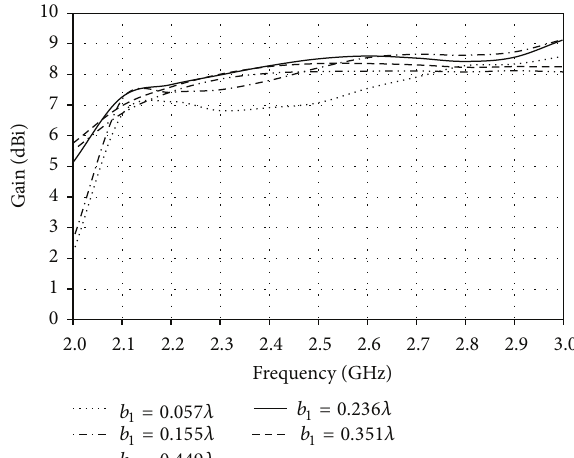
Figure 19: Simulated antenna gains for various heights of the parasitic coupling apertures ( 𝑏 1 ).